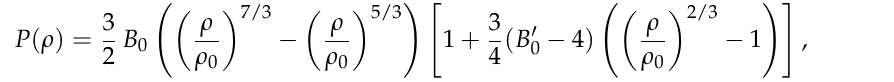
Figure 3. The c/a ratio as a function of P: QMD vs. the available experimental data from different literature sources [17,31,32].